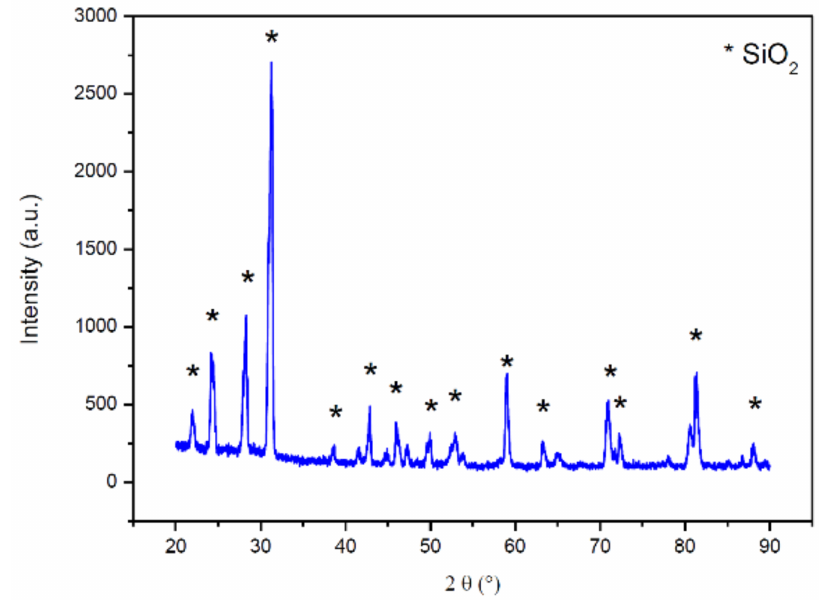
Figure 6. XRD diffraction of WFES mineralogical